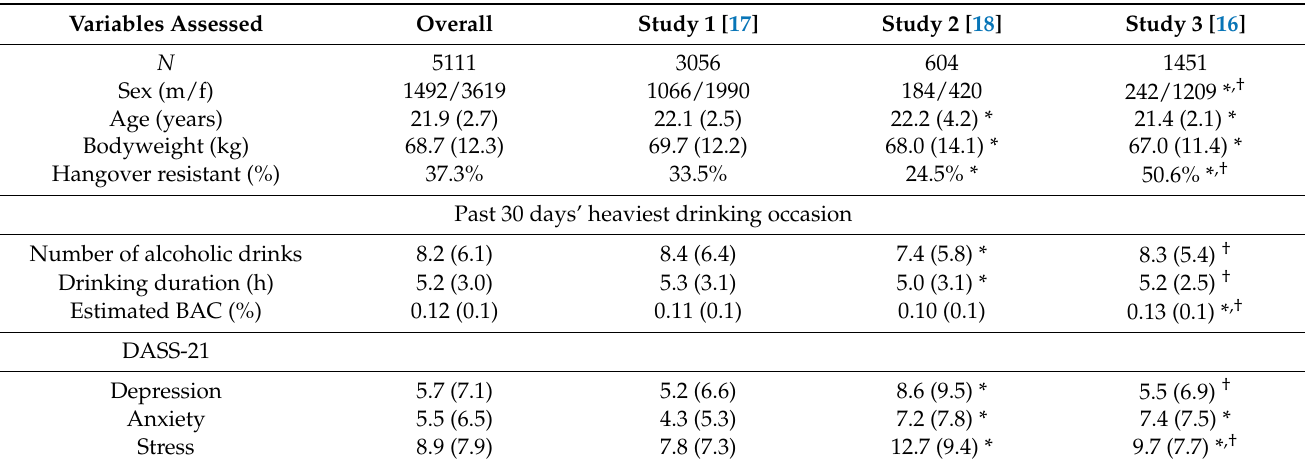
Table 1. Demographics and study outcomes.